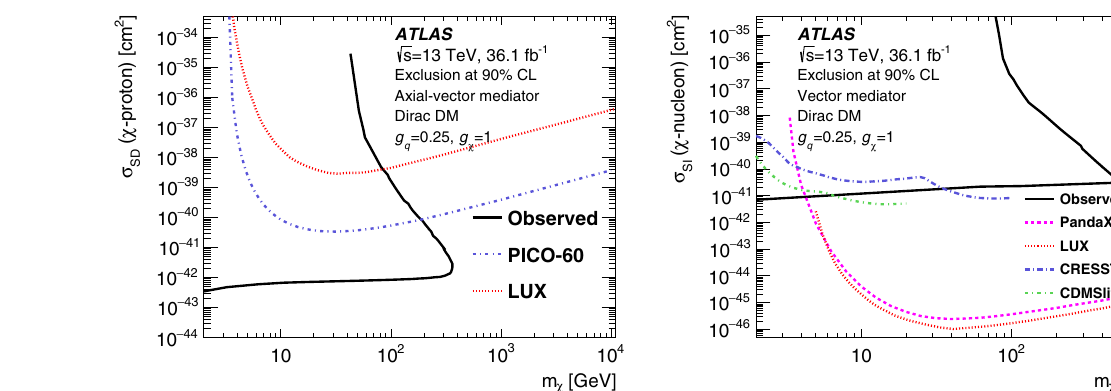
cross section in a simplified model of dark-matter production involving a vector operator, Dirac DM and couplings g q = 0 . 25 , g χ = 1 and g (cid:14) = 0 as a function of the dark-matter mass m χ ( right ); also shown are results at 90% CL from four direct dark-matter search experiments [80–83]